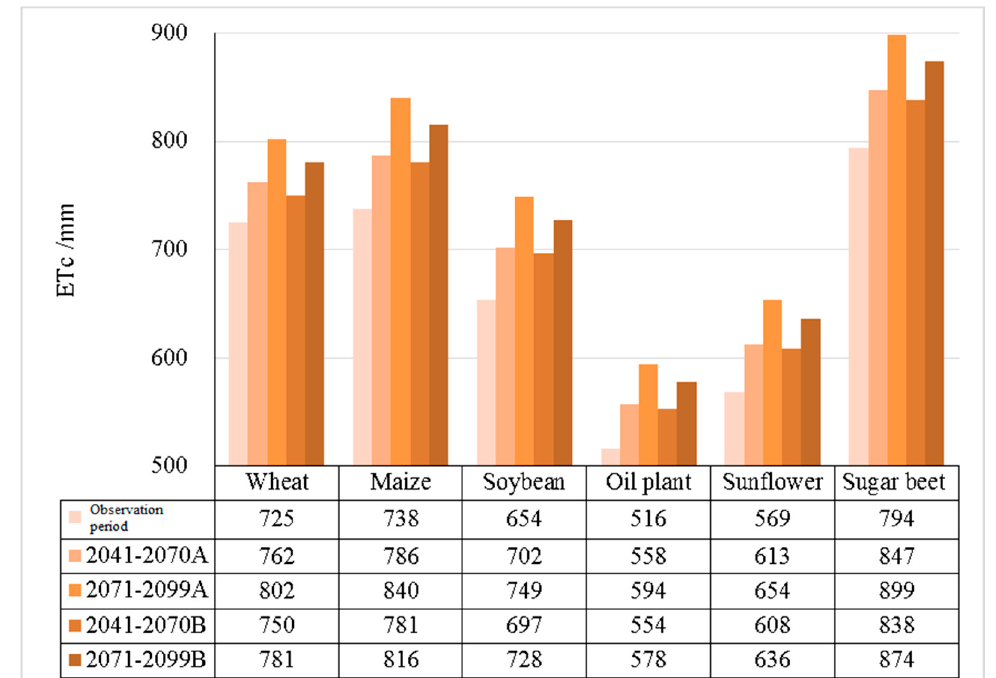
Figure 5. ET c of different crops in different time periods.